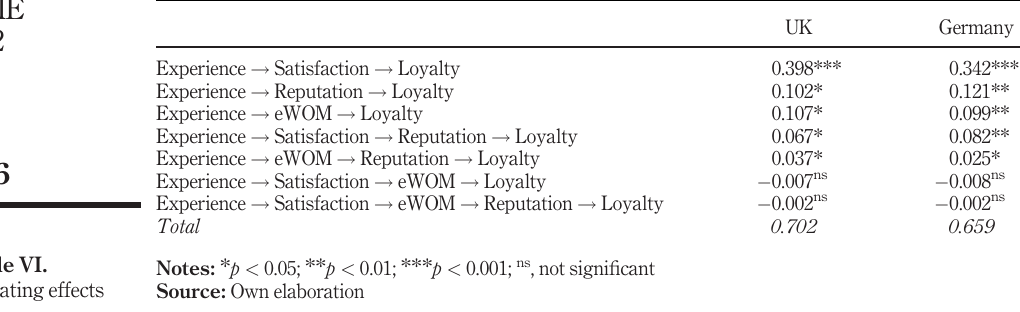
Table VI. Mediating